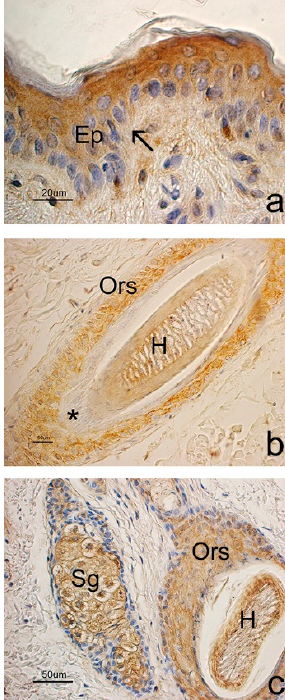
Figure 5. PDGFR α expression in the goat skin. ( a ) In the epidermis (Ep), immunostaining mainly extended in the suprabasal cell layers. Arrow points to basal cells. ( b ) Isthmic region of an anagen hair follicle (HF): immunostaining clearly involved all the cells of the outer root sheath (Ors) while inner root sheath was negative (*). A hair (H) is in the follicular canal. ( c ) A sebaceous gland (Sg): staining is mainly localized in the secretory cells while the gland basal cells are negative. On the right, a primary HF in a transverse section shows an intense staining to PDGFR α in the outer root sheath (Ors) cells. H = hair. ABC immunohistochemical staining. Nuclei are counterstained with Hematoxylin.